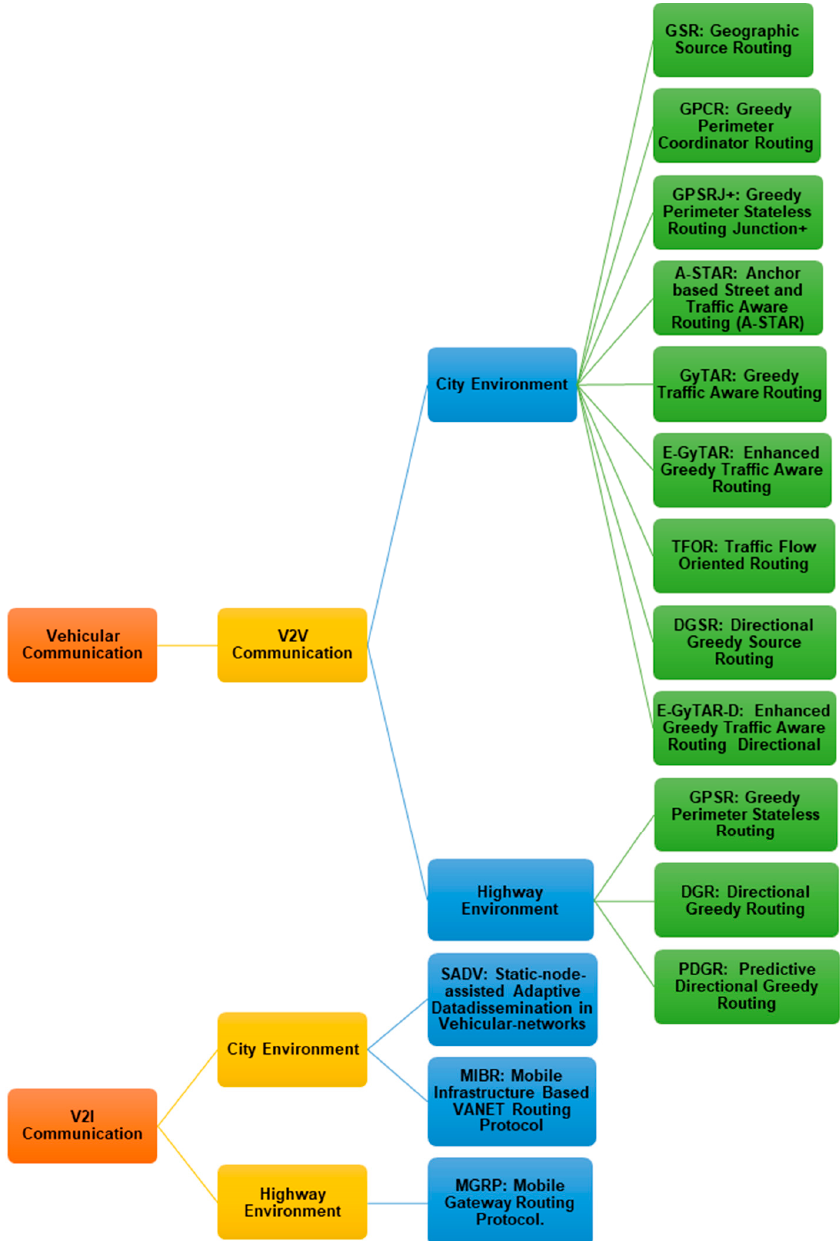
Figure 8. Categories of protocols on vehicular communications.